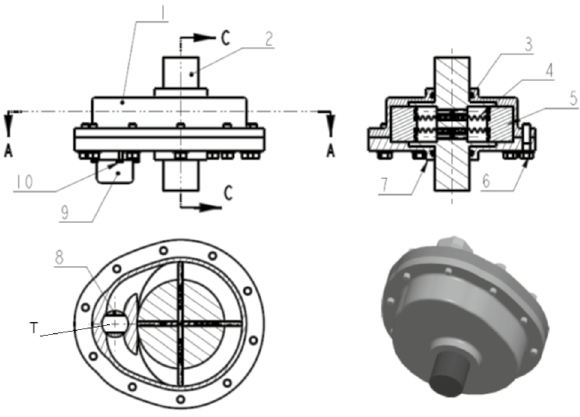
Figure 1. Structure of the rotational hydraulic damper. (Creo/parametric, trial version. www. ptc. com/ produ cts/